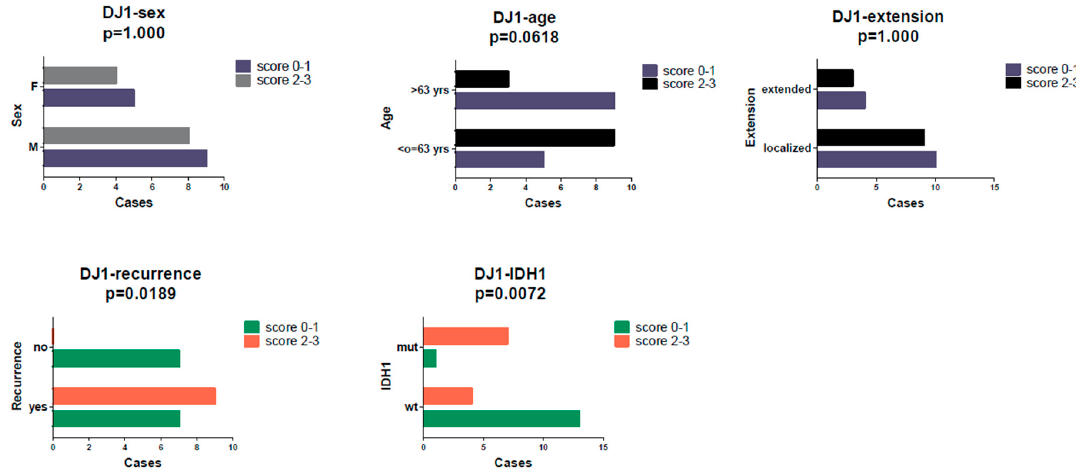
Figure 3. A high DJ-1 immunoscore (2–3) was associated with a higher recurrence rate ( p = 0.0189) and IDH mutation.